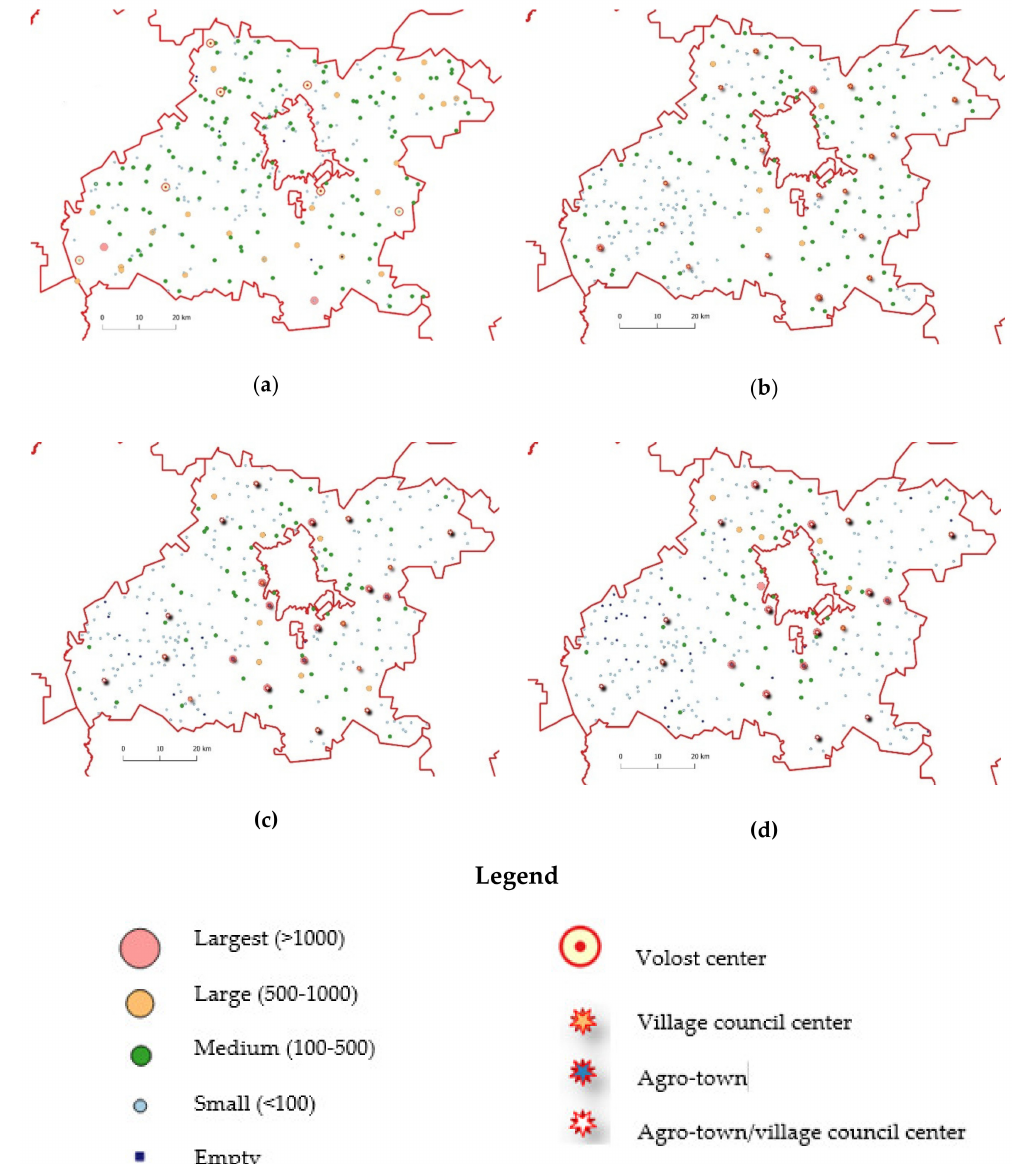
Figure 4. The locality network within the current boundaries of the Mogilev district ( a ) 1909; ( b ) 1990; ( c ) 2007; ( d )